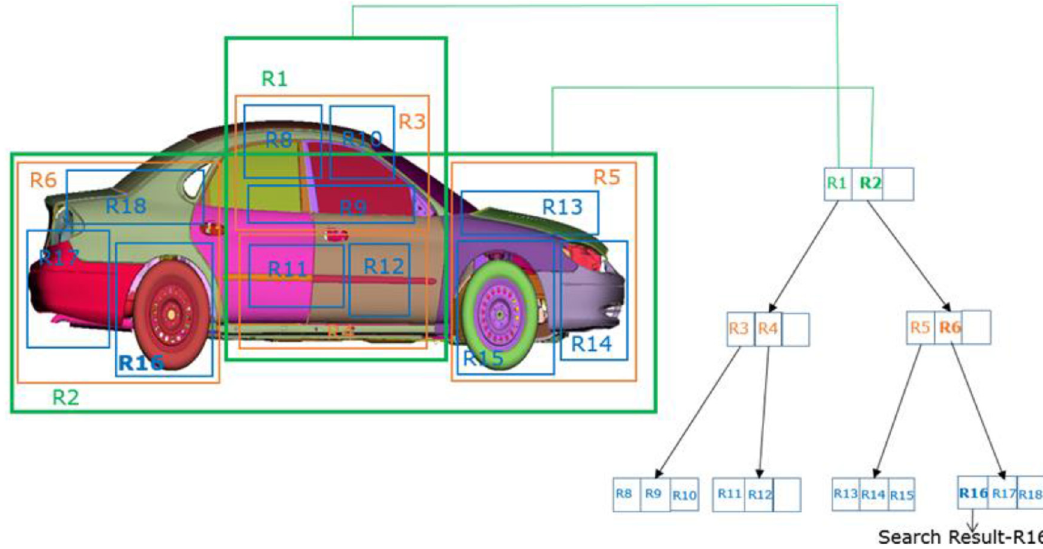
Fig. 5. R-Tree representation for full car assembly.